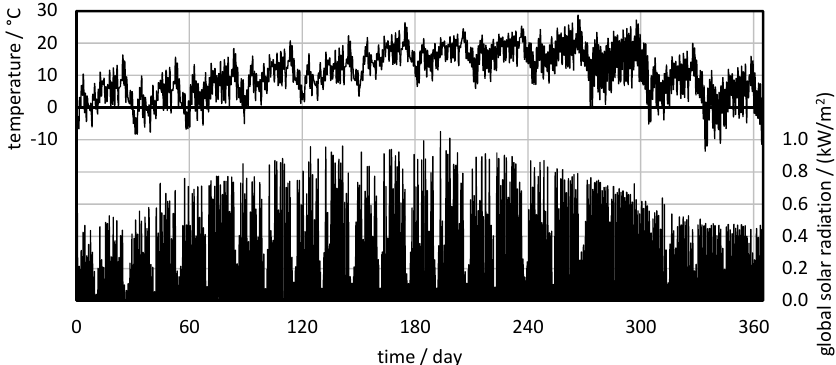
Figure 10. Reference meteorological data used in the developed models.